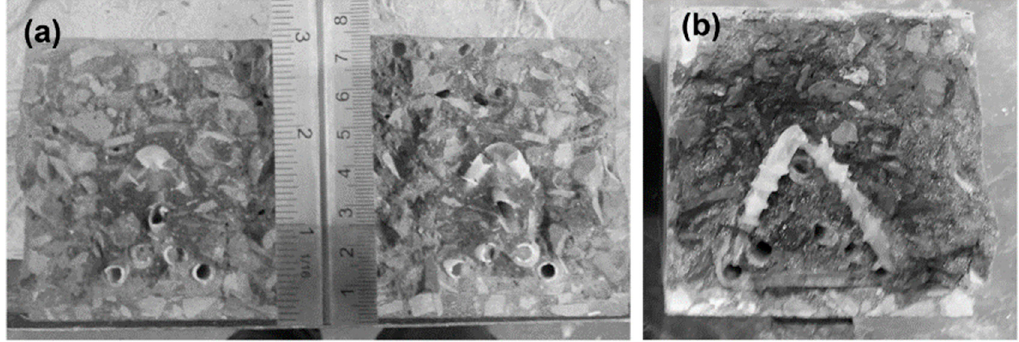
Figure 10. Group 2: ( a ) spacers blocks employed to control the movement of the TETs; ( b ) expansion area of the healing agent.